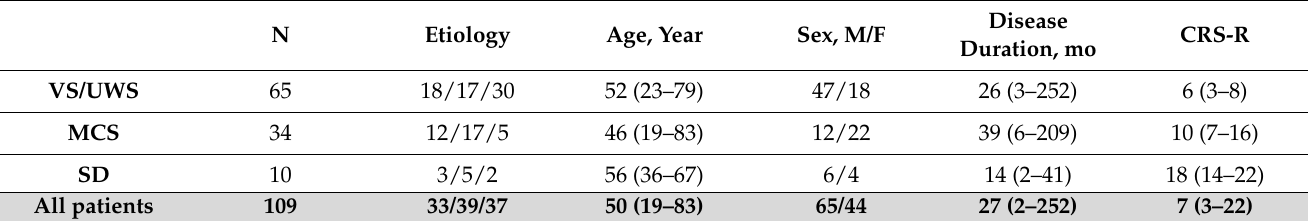
Table 1. Summary of demographic and clinical variables. Etiology is reported as traumatic/vascular/ anoxic. Age, disease duration and CRS-R scores are given as median (range). Abbreviation: N = number of patients; VS/USW = vegetative state/unresponsive wakefulness state; MCS = minimally conscious state; SD = severe